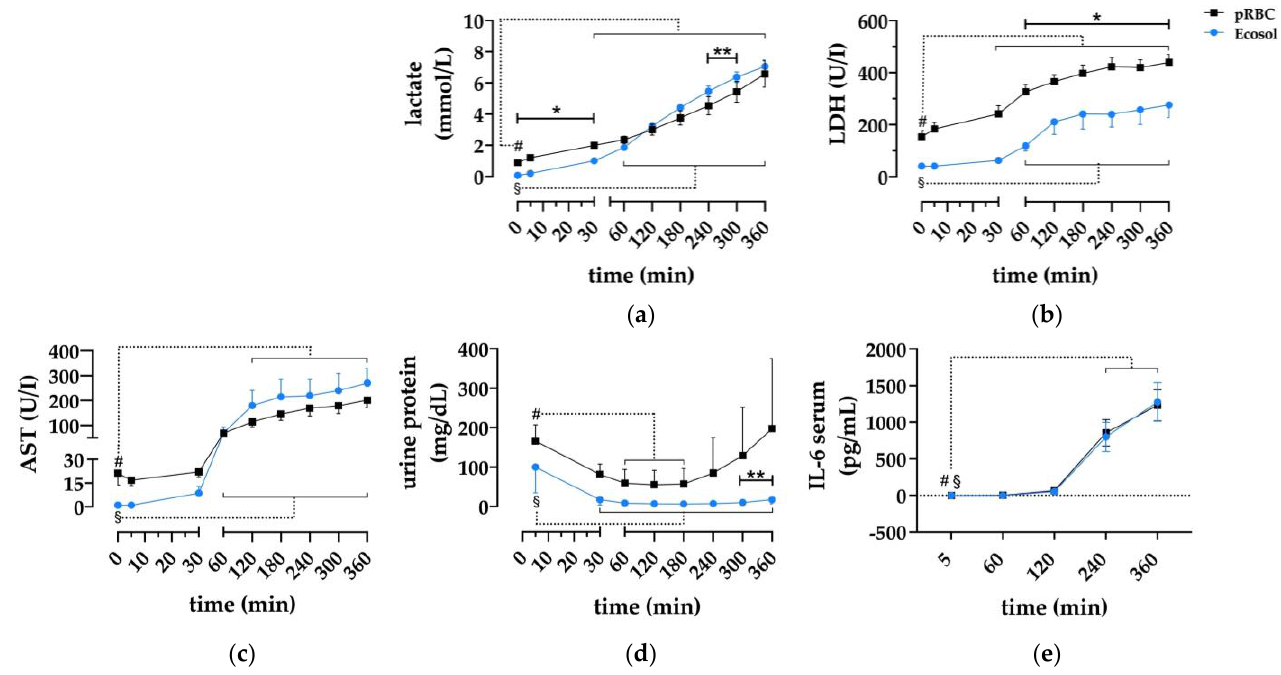
Figure 4. Evaluation of kidney damage parameters. ( a – c ) Serum concentrations of AST, LDH and